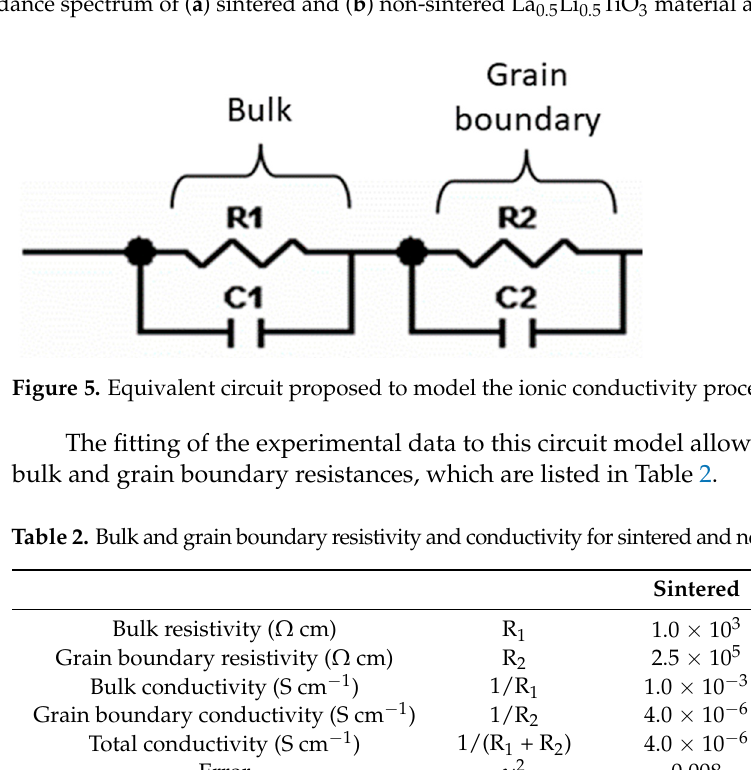
Figure 4. Impedance spectrum of ( a ) sintered and ( b ) non-sintered La 0.5 Li 0.5 TiO 3 material at 25 °C.